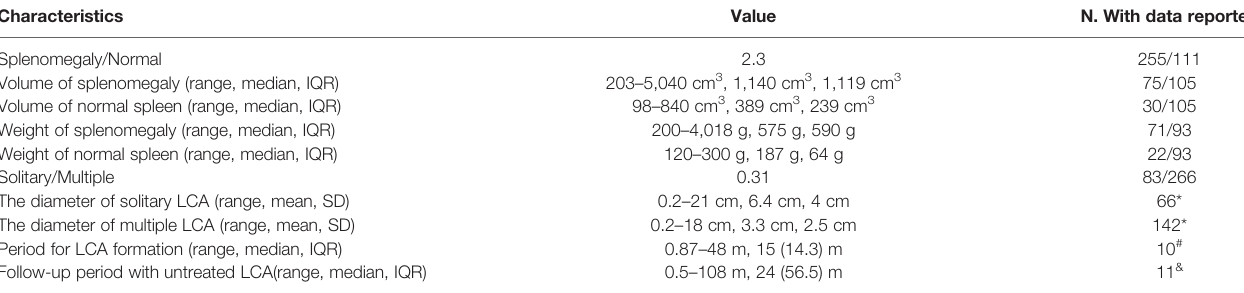
TABLE 4 | Characteristics of spleen and